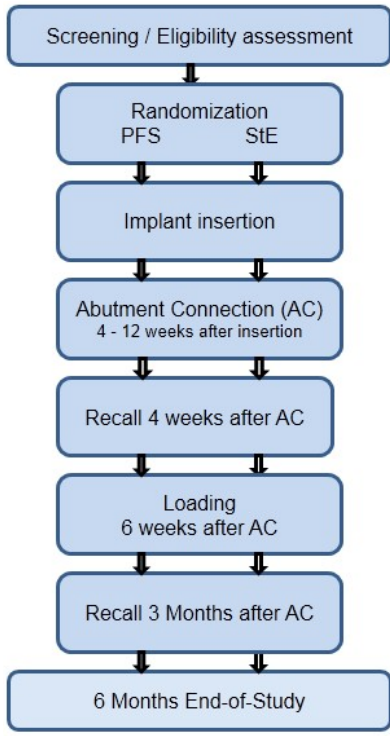
Figure 1. Study flow chart: overview of assessments. PFS, platform